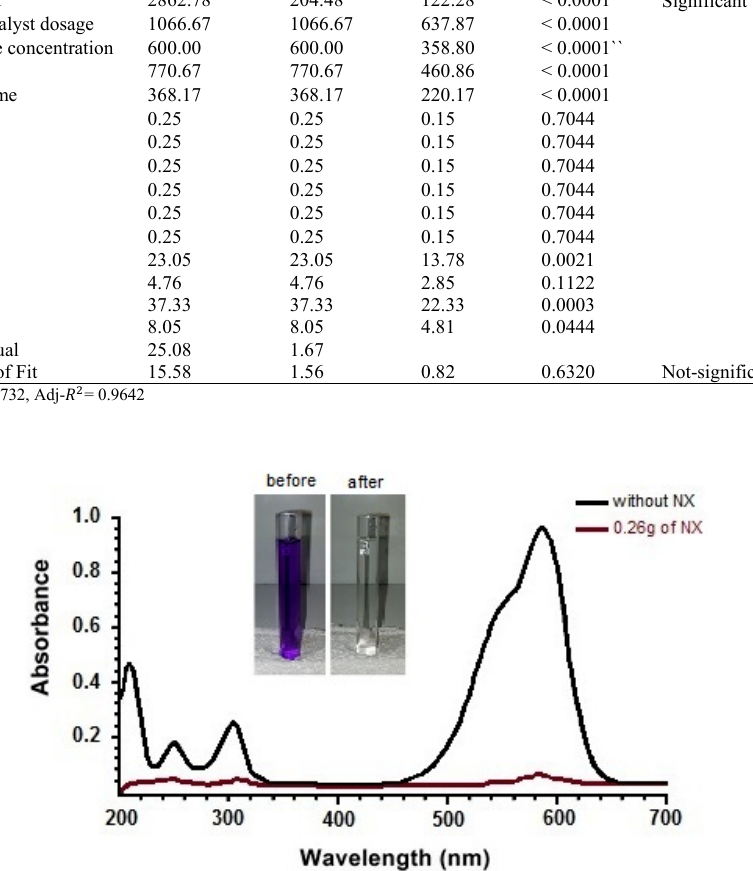
Fig. 3. UV–vis absorbance spectra of decomposed CV solution over NX. The inset shows the photos of dye solutions before and after adsorption. (sonication time 6min, catalyst mass 0.26 g, pH of solution 8, concentration of dye 13 mg L -1 ).